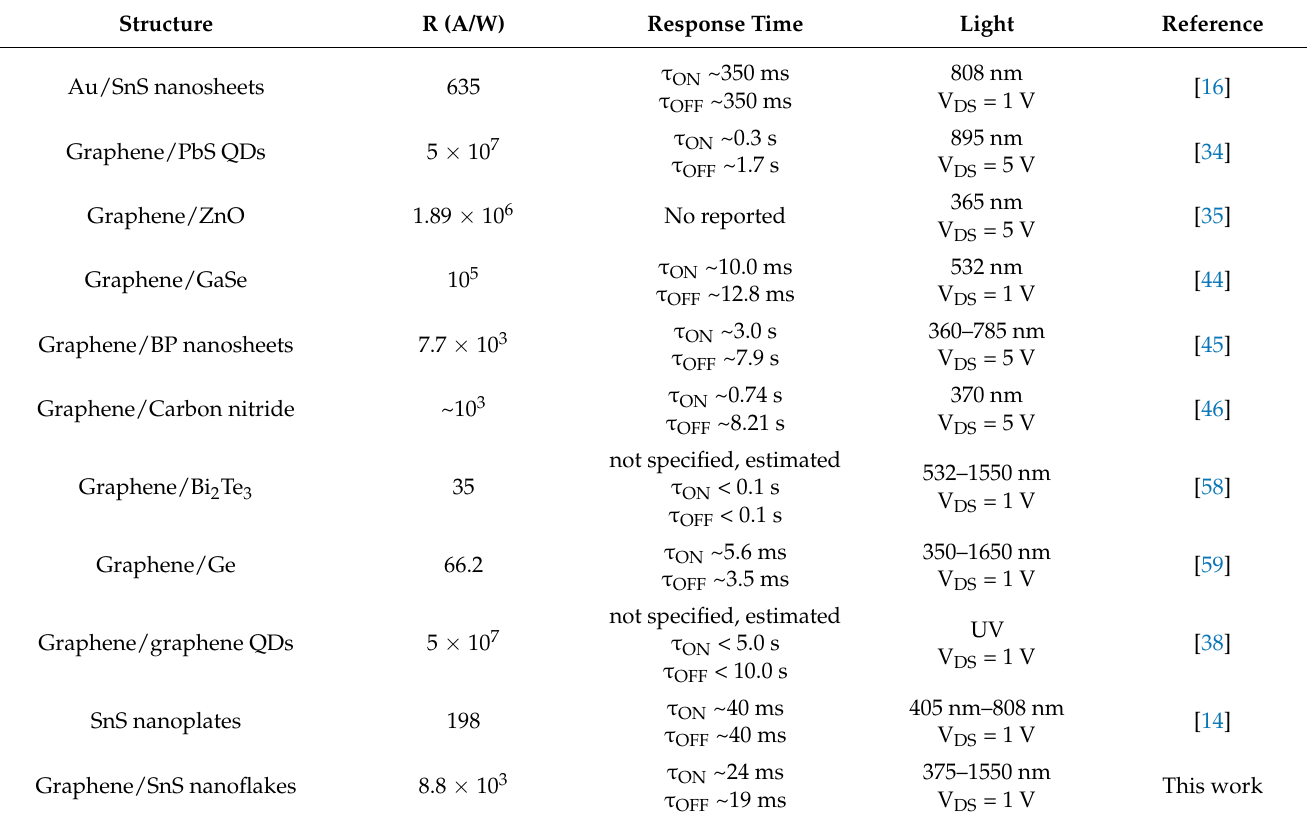
Table 1. Comparison of the recent graphene/nanostructure and 2D SnS photodetectors. Structure R (A/W) Response Time Light